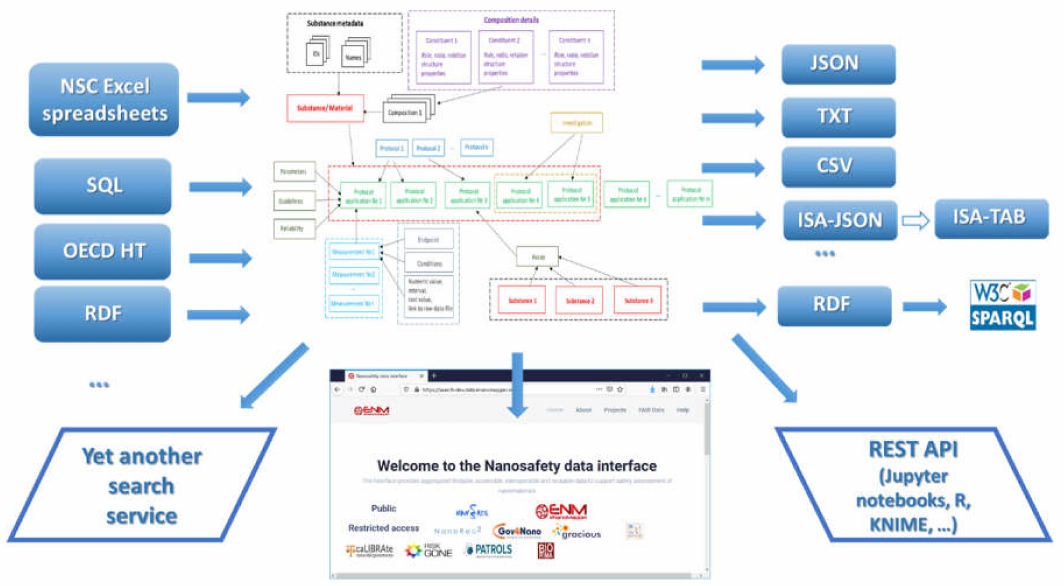
Figure 3. Data input and output to eNanoMapper / Ambit